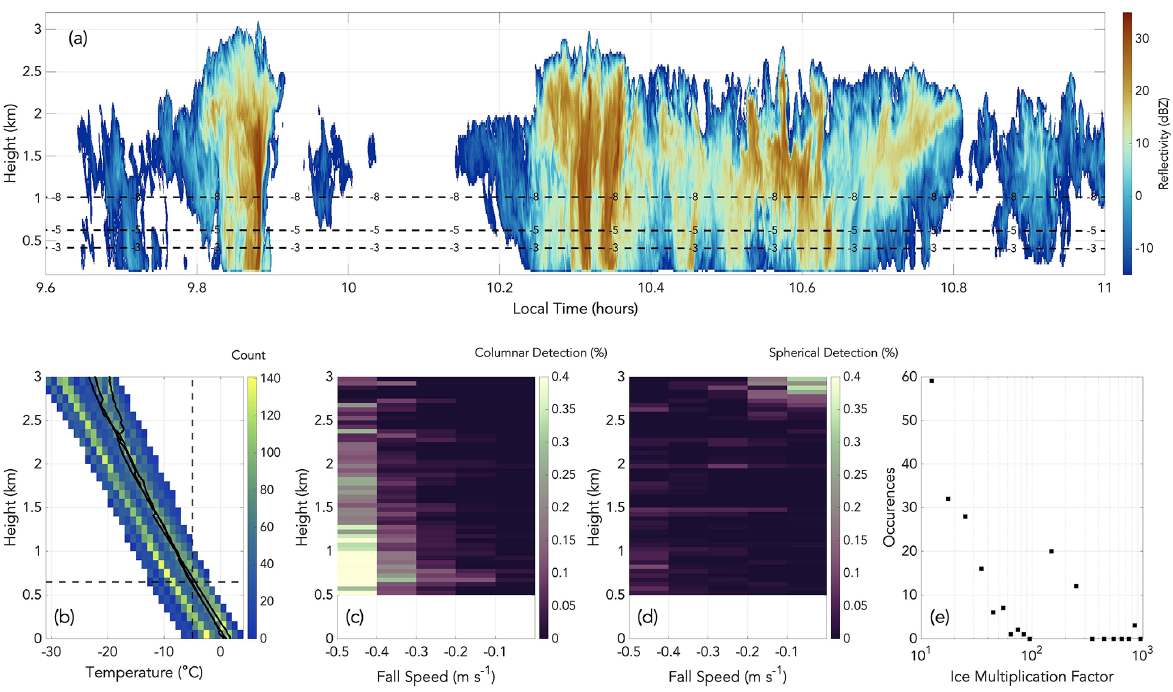
Figure 9. For 31 December 2019, (a) time–height mapping during 09:36–11:00LT of KAZR radar reflectivity (colors) and INTERPSONDE isotherms (dashed black lines), (b) a joint PDF of temperature and height (colors) from 32 radiosondes launched during the 13 cases along with the three temperature profiles from 31 December (black), and the percentage of Doppler spectra with columnar detections (c) and spherical detections (d) in each fall speed–height bin during 00:00–18:15LT. Prepared using Crameri